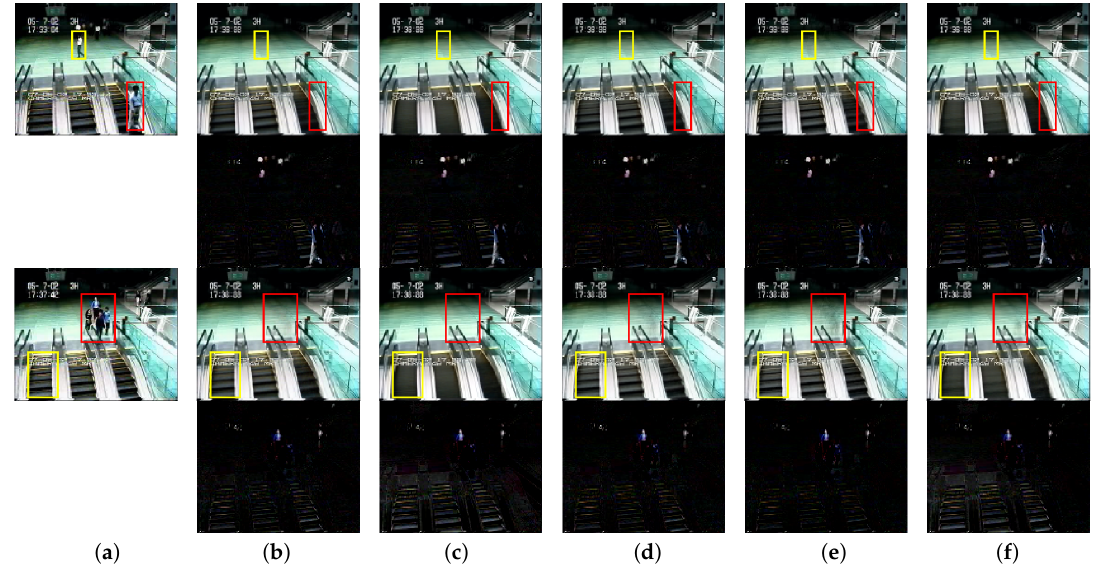
Figure 5. Background modeling: two example frames from Escalator sequences are shown. ( a )